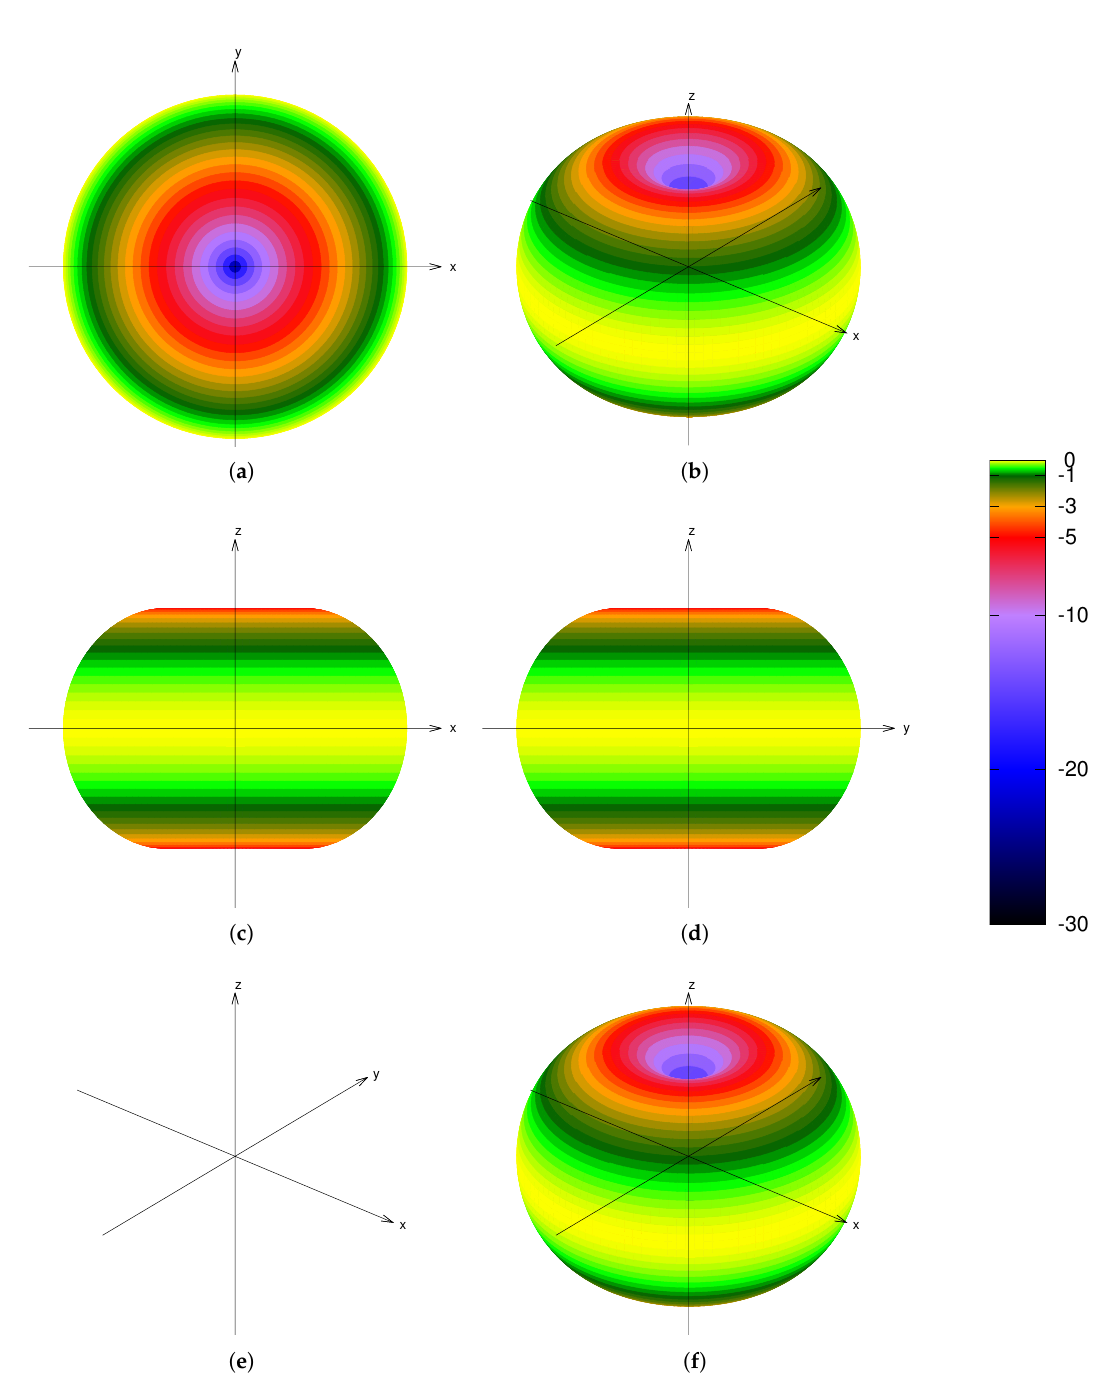
Figure 3. Free-space, far-field 3-dimensional simulated pattern (dB) for the SeaSonde transmit antenna. ( a ) shows the plan view while ( c , d ) show the side and front elevations of the pattern. The remaining oblique views, ( b , e , f ) show the radiation patterns for the combined, horizontal and vertical polarisations respectively. The images show relative directional antenna gain and are mapped with the ( − 30 dB,0 dB ) (cid:55)→ r = ( 0,1 ) radius of the unit sphere. Gain is normalized such that 0 dB (cid:55)→ 1.08